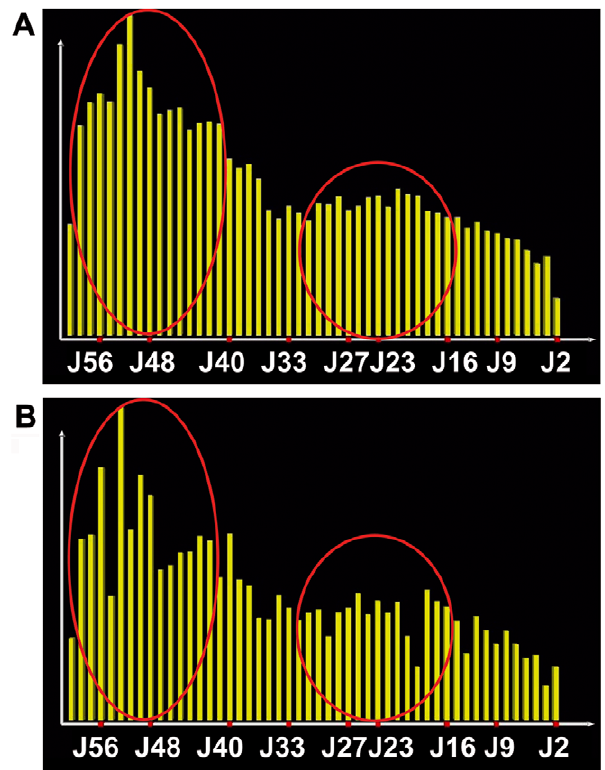
Figure 4. Representation of the V14 family rearrangement frequencies. Y axis represents the cumulated frequencies of all V14 genes with the J genes presented on the X axis, (A) without correction for RSS scores, (B) with correction accordingly to RSS scores. The two red ellipses show the localization of the two Hot Spots of